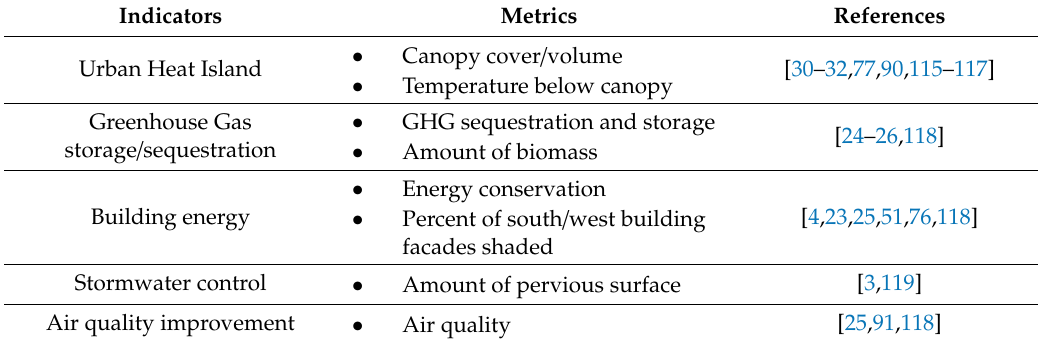
Table A2. Climate